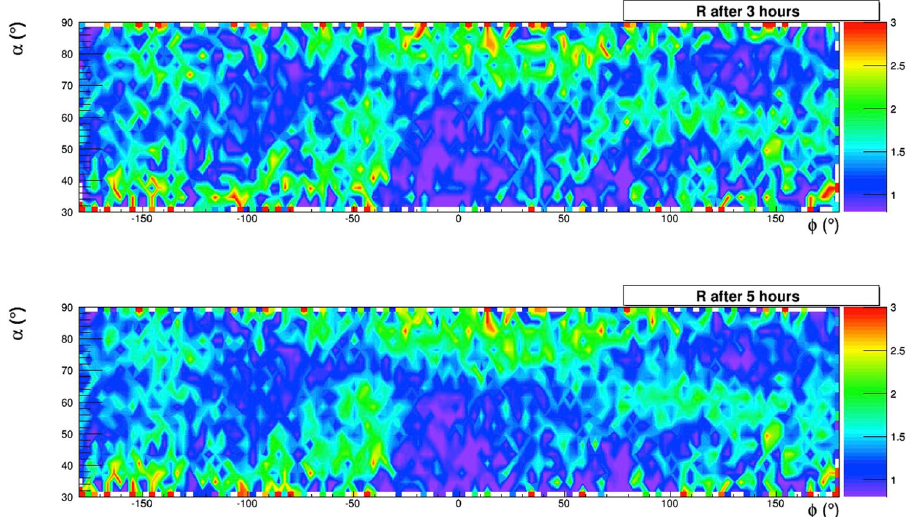
Figure 18. Time sequence of muographies obtained in 5 hours of data taking. The drawing was obtained using the software root .